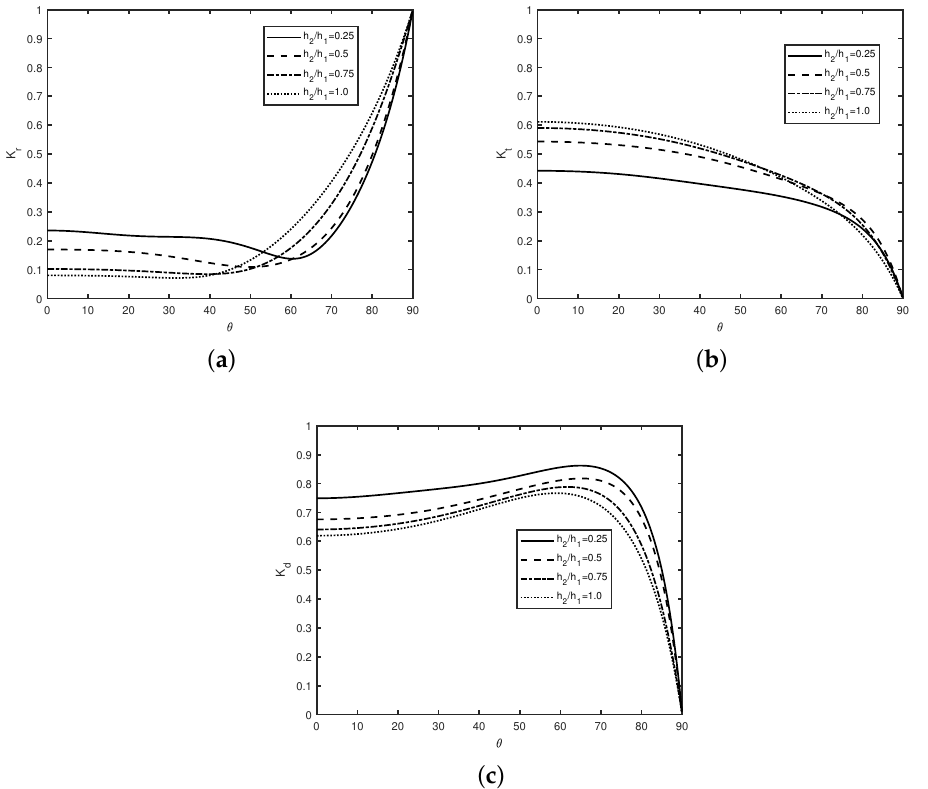
Figure 9. Variation of ( a ) reflection coefficient K r , ( b ) transmission coefficient K t , and ( c ) dissipation coefficient K d versus angle θ for different values of h 2 / h 1 with breakwater width w / h 1 = 1.0, C f = 0.5, d / h 1 = 2 and N =